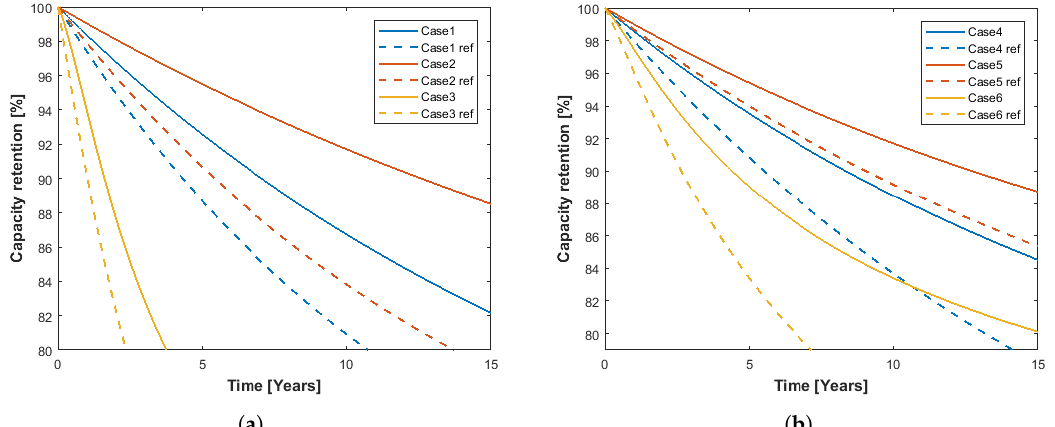
Figure 10. Model result for the three different vehicles at 30 ◦ C while used according to ( a ) User 1; and ( b ) User